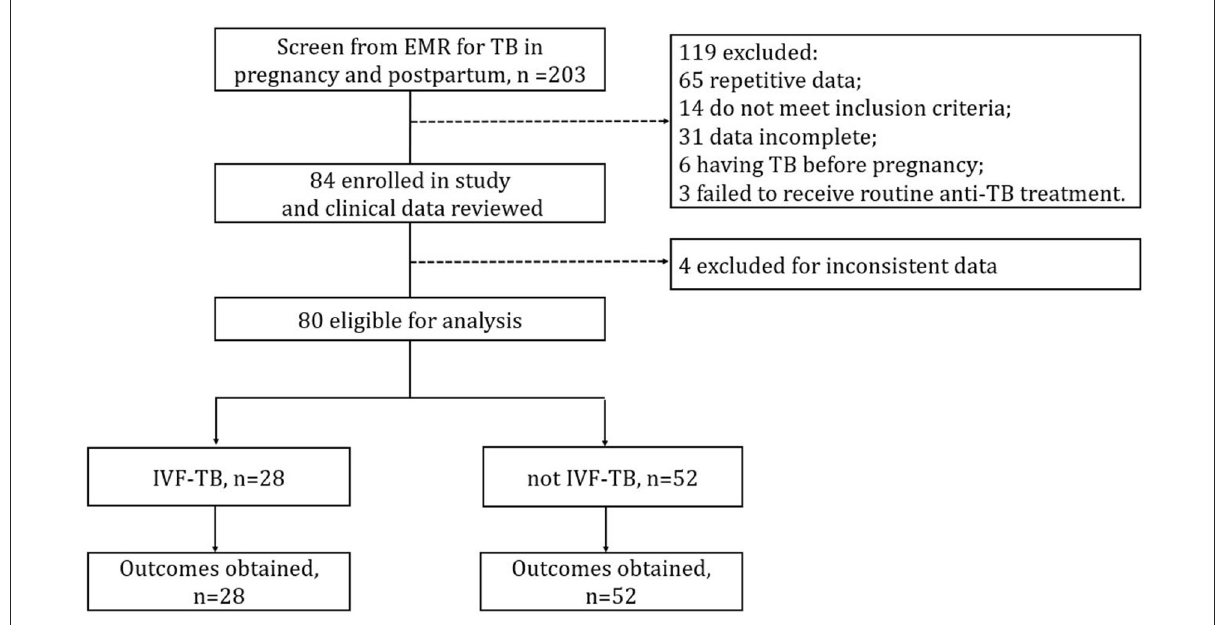
FIGURE1 Flow chart of participants and data collection. EMR, electronic medical record; IVF, in vitro